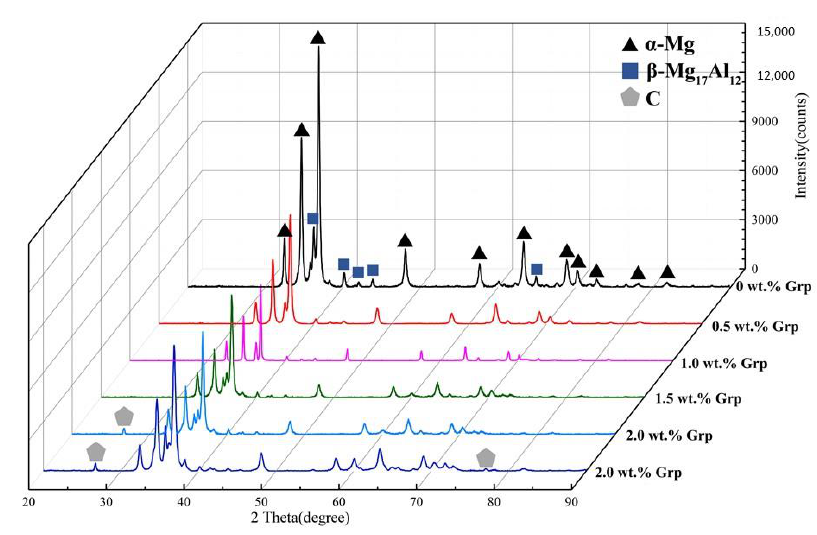
Figure 3. XRD pattern of Grp/AZ91D composites.